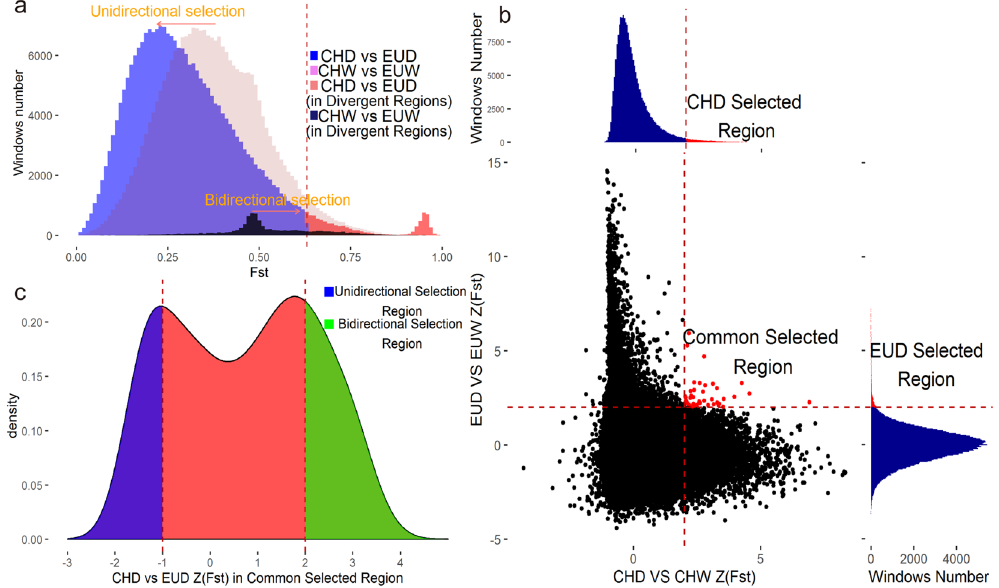
Figure 3. Genomic regions with selection signals during pig domestication. ( a ) Distribution of Fst between each group. The blue region indicated the distribution of CHD vs. EUD’s Fst. The pink region indicated the distribution of CHW vs. EUW’s Fst. The divergent region marked red in this graph is defined as CHD_vs_ EUD’s Fst being great than 0.61 (ZFst > 2), and the black part is the distribution of CHW vs. EUW’s Fst in the same region. ( b ) Distribution of EUD vs. EUW’s ZFST and CHD vs. CHWs ZFst, which are calculated in 20-kb windows sliding in 10-kb steps. Data points located to the left and right of the left and right vertical dashed lines, respectively (corresponding to the rights tails of ZFst in CHD vs. CHW and EUD vs. EUW, where the ZFst ratios are both 2), and above the vertical dashed line or horizontal dashed line were identified as selected regions for Chinese domestic pigs and Europe domestic pigs, respectively. The shared selected regions were identified as common selected regions. ( c ) Distribuation of CHD vs. EUD’s ZFst in common selected regions. The right tail marked green correspond to the region with CHD vs. EUD’s ZFst above 2.The left tail marked blue correspond to the region with CHD vs. EUD’s ZFst less than